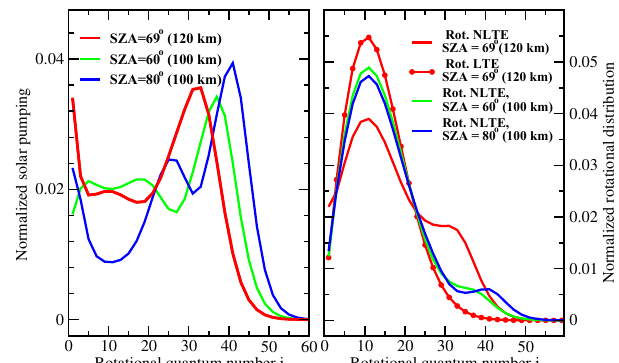
Figure 2. Left – normalized distribution of radiative pumping at level 10011 of 12 C 16 O 2 due to the absorption of the 2.7µm solar radiation for altitudes of 100 and 120km. Right – normalized ro- tational distribution at level 10011 of 12 C 16 O 2 for altitudes of 100 and